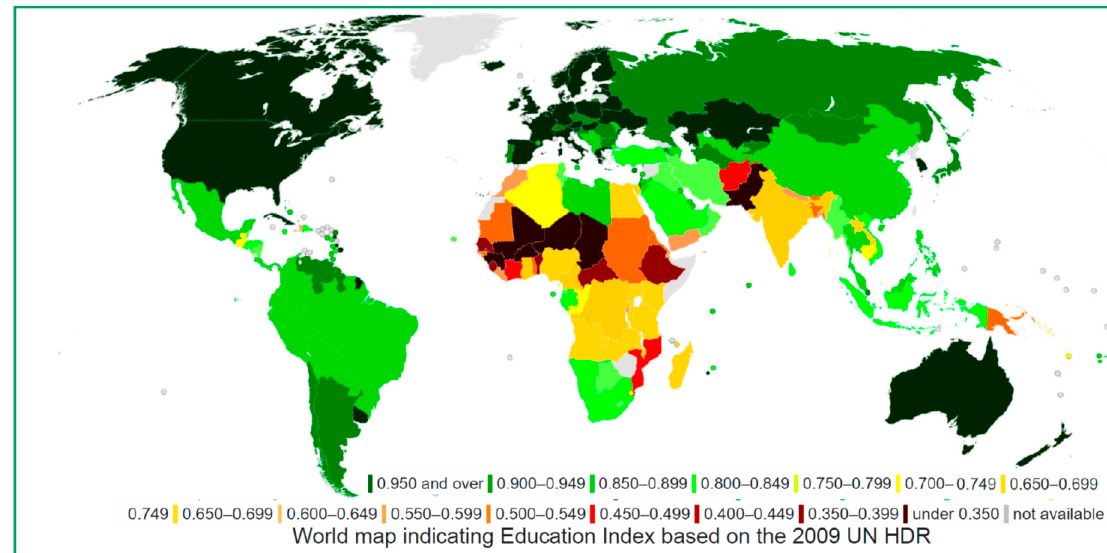
Figure 5. Geographical distribution of education index: mean years of schooling and expected years of schooling.